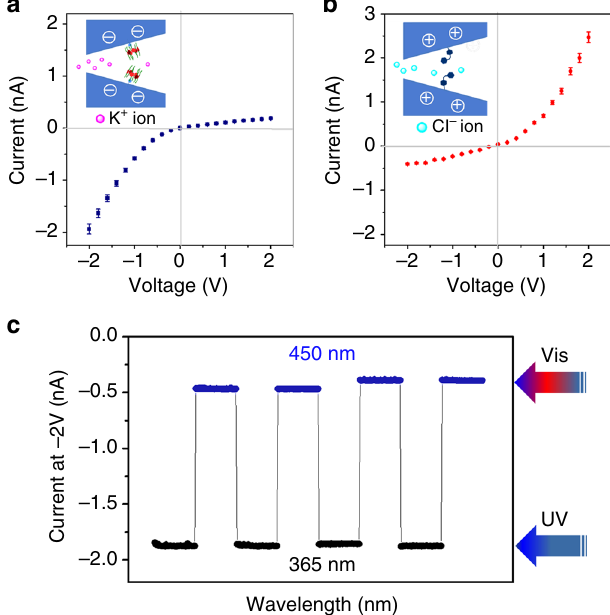
Fig. 4 The ion selectivity of light-controlled mechanisms. a Analysis via current recording of the nanochannels before UV light irradiation. b Analysis via current recording of the nanochannels after UV light irradiation. c The reversibility of the different states of the P6A-based nanochannels by measuring the current after alternating irradiation with different light